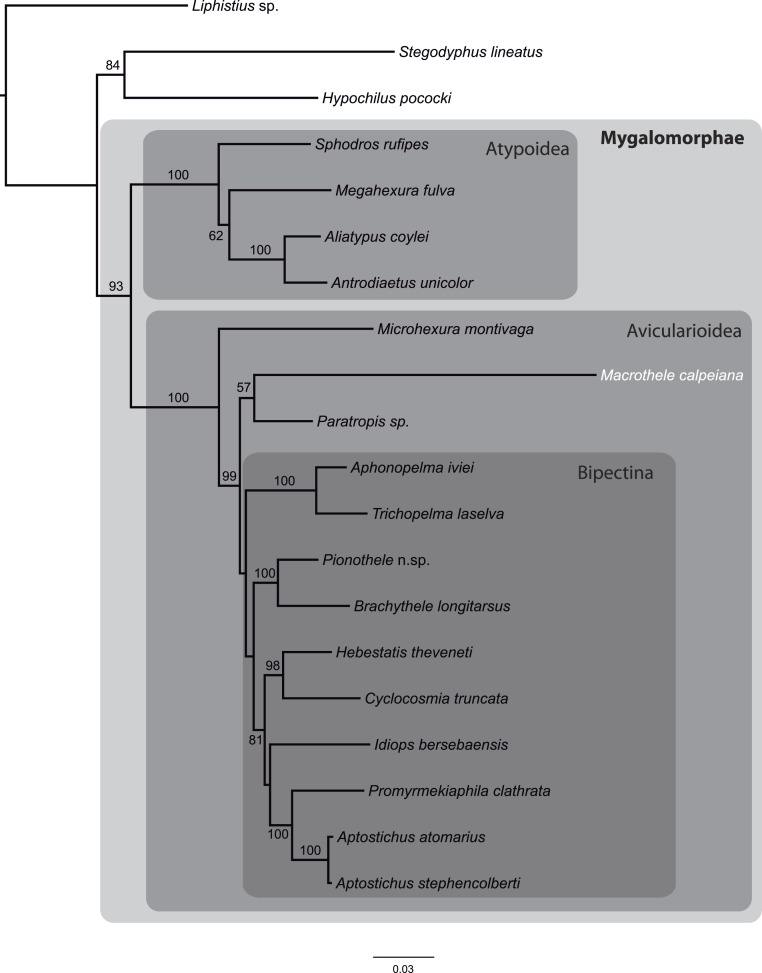
Phylogenetic relationships of major Mygalomorphae lineages sampled.ML tree showing the phylogenetic relationships of major Mygalomorphae lineages sampled. The analysis is based on a supermatrix of 35 putative orthologs (4,531 amino acids). Numbers indicate bootstrap support values >50%.